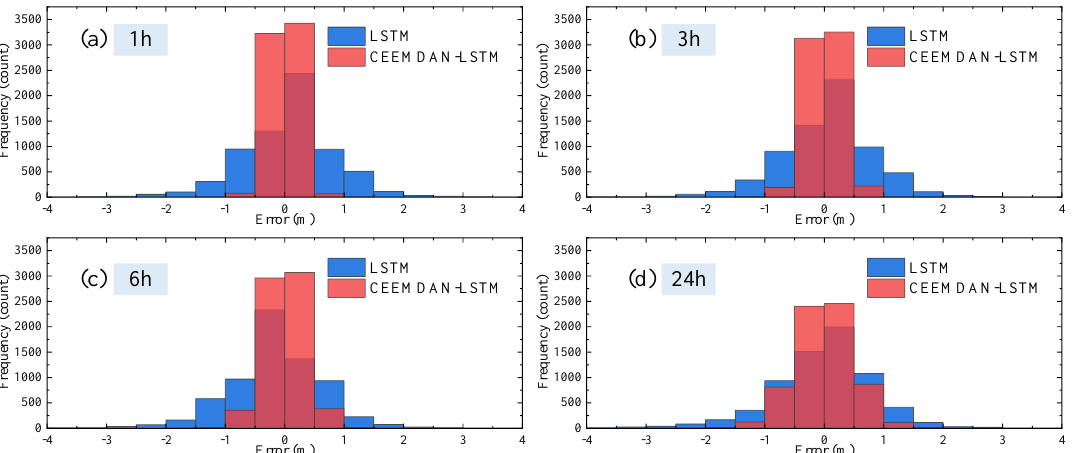
Figure 13. Comparison of ShiDao measured and predicted values by LSTM (blue) and CEEMDAN- LSTM (red) SWH (m) forecasts with ( a ) 1-, ( b ) 3-, ( c ) 6- and ( d ) 24-h window.